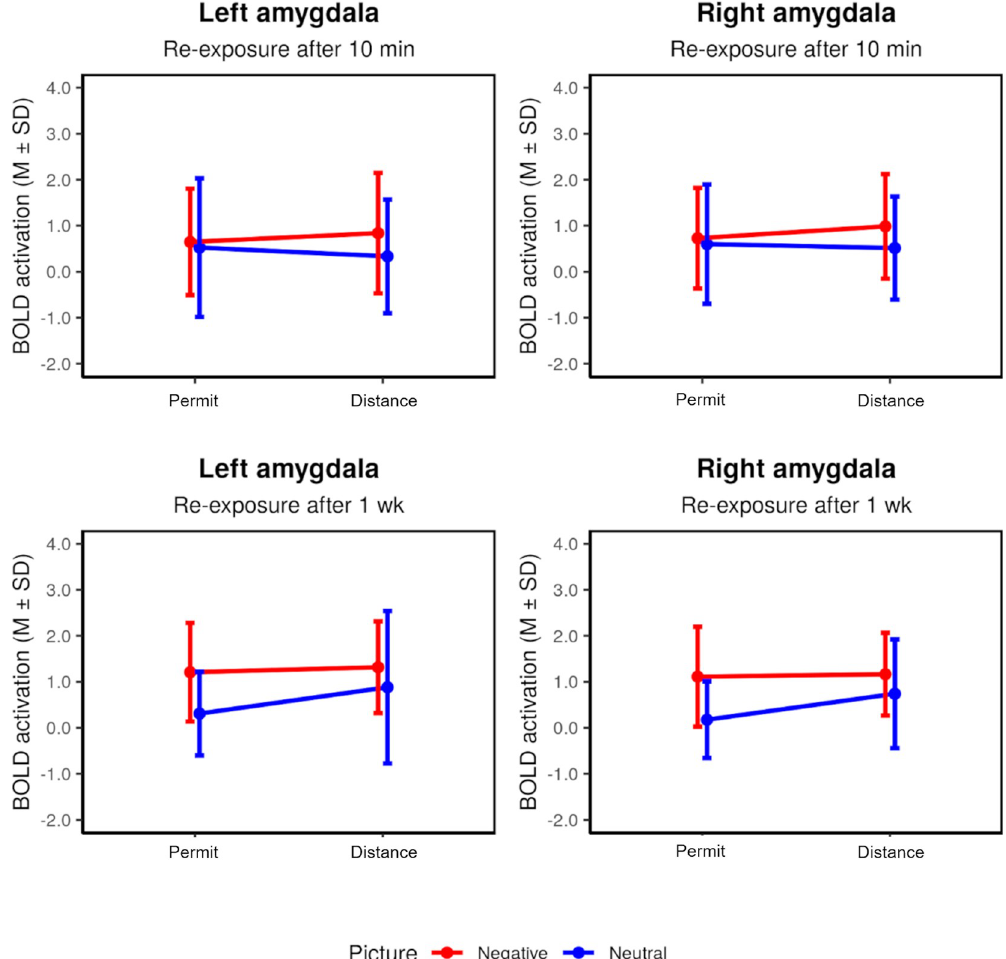
Fig 5. Summary statistics for the amygdala ROI during re-exposure after 10 min (short-term effects, timepoint 3) and after 1 week (long-term effects, timepoint 4).